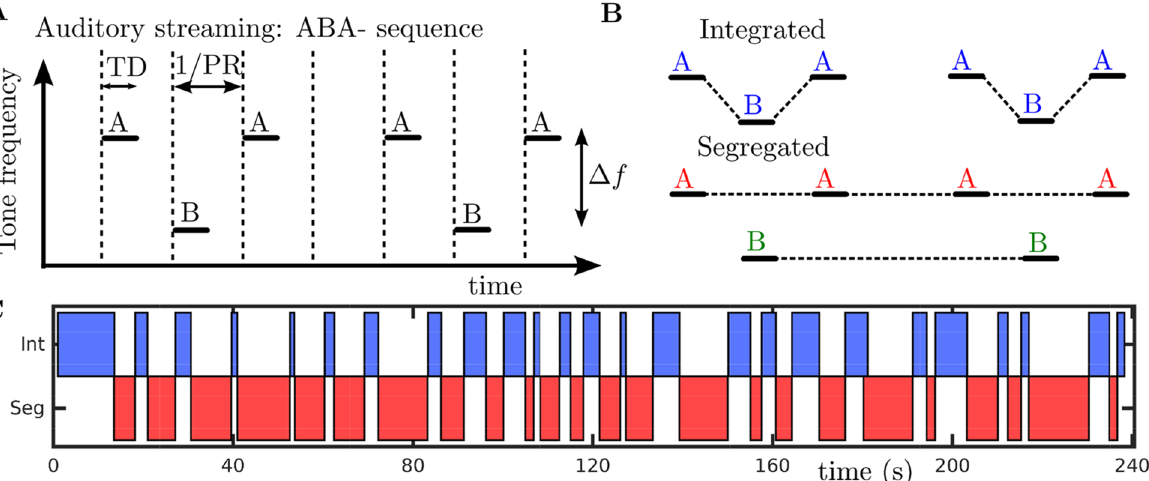
Fig 1. Stimulus paradigm and two possible percepts. A : Repeating ABA- triplet sequences (two triplets shown) consist of higher frequency pure tones A interleaved with lower frequency pure tones B of duration TD separated by a frequency difference Δ f . The time between tone onsets (dashed vertical lines) is inverse of the presentation rate 1/ PR (the “ - ” in “ ABA- ” represents a silence of duration 1/ PR ). Throughout this paper tone duration will be set to TD = 1/ PR such that offset of an A tone abuts the onset of the next B tone. B : The stimulus is perceived as either integrated into a single stream ABA-ABA- or as two separate streams A-A-A-A- and -B — B – . C : Subject reports of integrated and segregated from a single 4-minute trial (480 triplets) at Δ f = 5 st and PR = 8 Hz.